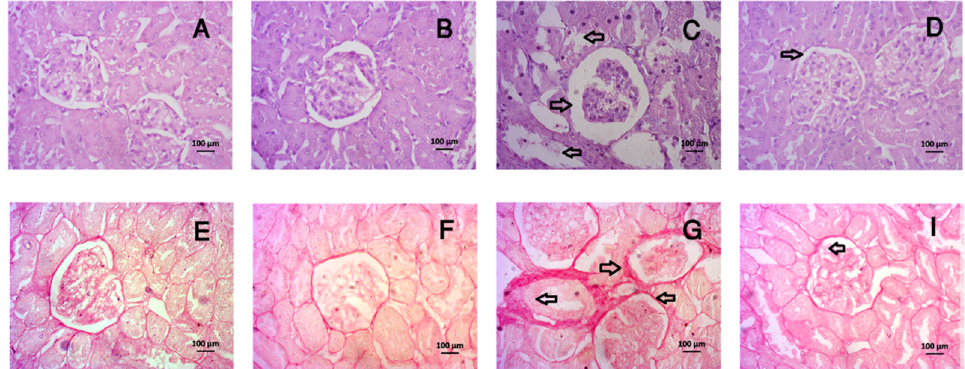
Figure 9. Effect of tempol on kidney histology in CCl 4 -administered rats. In this figure ( A – D ) is hematoxylin and eosin staining and ( E – H ) is Sirius red staining. Here, ( A , E )—Control; ( B , F )—Control + tempol; ( C , G )—CCl 4 and ( D , H )—CCl 4 + tempol. All pictures were taken at 40× magnification.